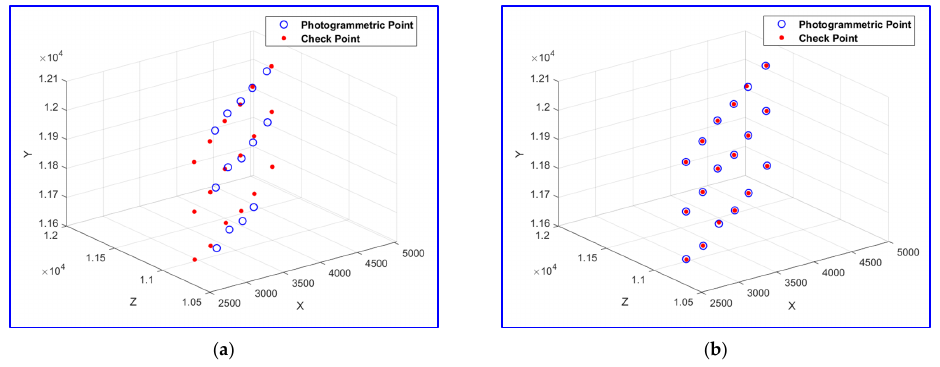
Figure 6. Eighteen target checkpoint locations before and after scale adjustment of the relative orientation parameter. ( a ) Before scale adjustment; ( b ) after scale adjustment. Table 2. Location error of the checkpoints by the determined ROPs (mm).